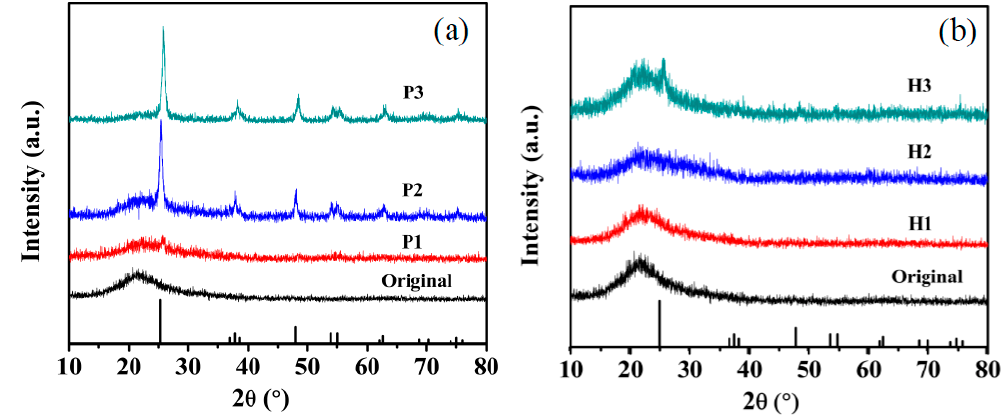
Figure 5. XRD spectra of ( a ) plasma treated at different power, ( b ) heating treated at different temperature.